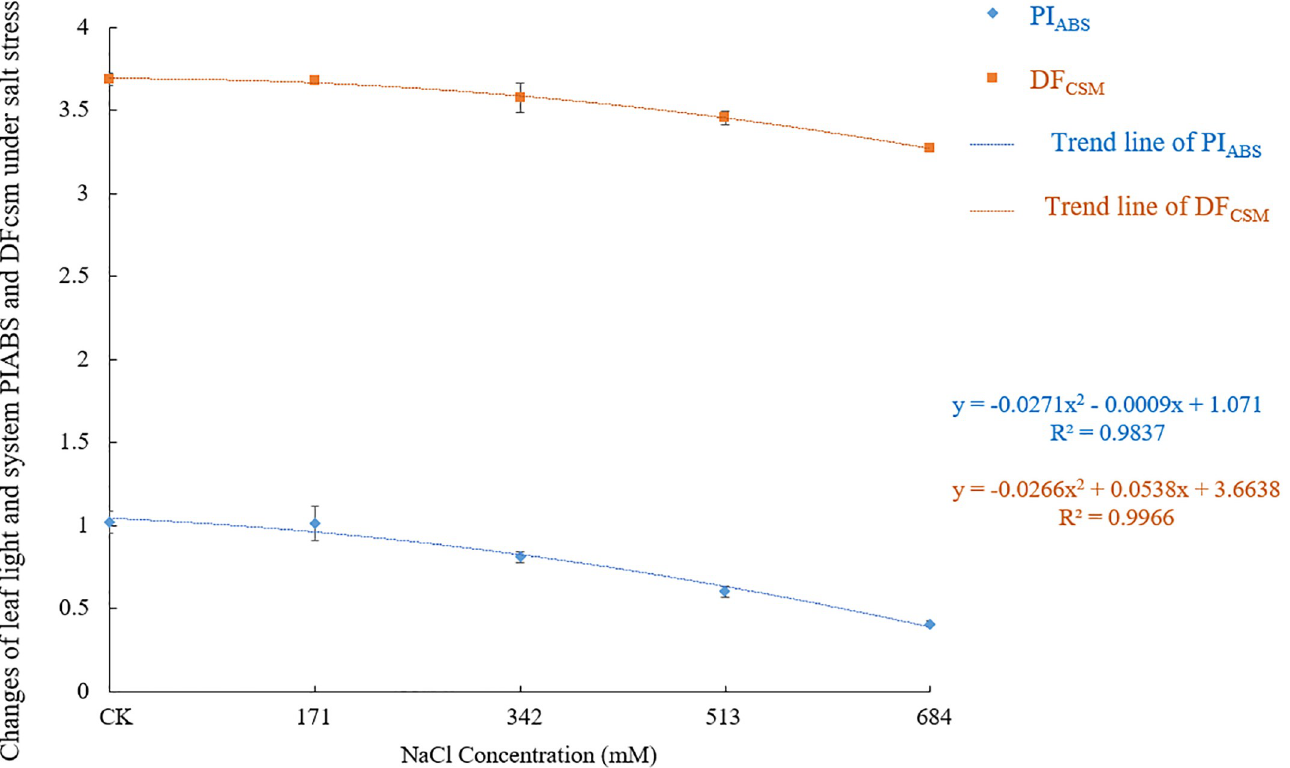
Fig 12. The changes of performance index and driving force (PI ABS and DF CSm ) under different salt stress.